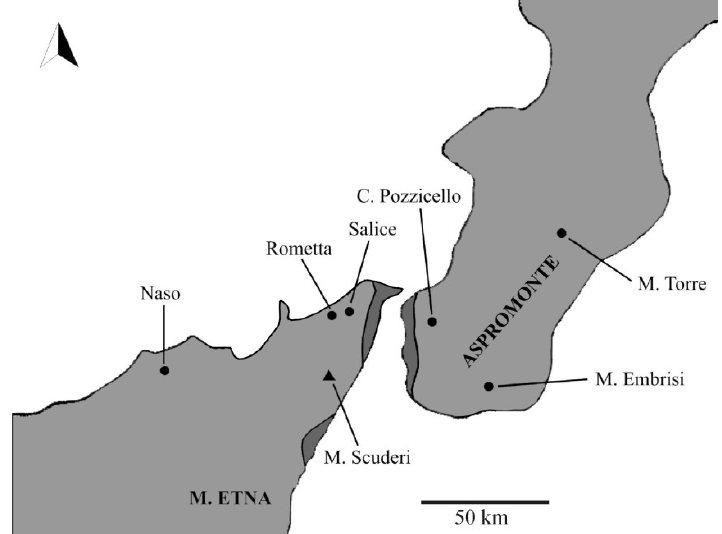
Figure 2. Late Middle Pleistocene palaeogeography of the Messina Strait area. Dark gray: littoral environment deposits of the “Messina Formation”. Light gray: lands. Modified after Barrier [43] and Lentini et al .